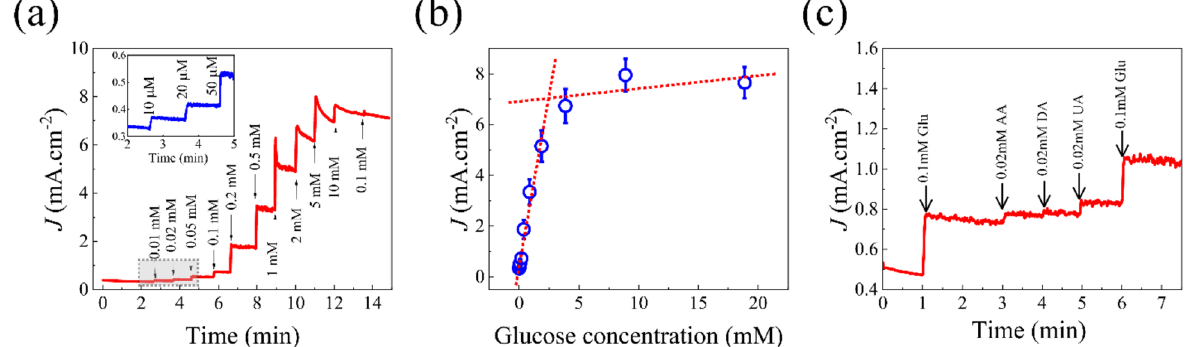
Figure 3. Amperometric study of Cu–Ni electrode: ( a ) Amperometric response of the Cu–Ni thin film electrode to successive addition of glucose in 0.1 M NaOH at an applied potential of 0.65 V, ( b ) corresponding calibration curve, and ( c ) amperometric response of the Cu–Ni thin film electrode to interferences AA, DA and